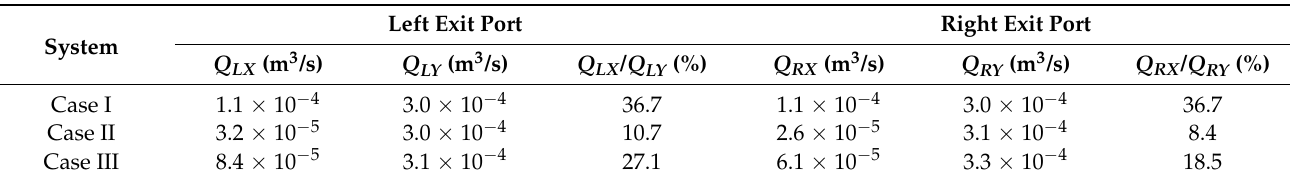
Figure 9. Hydrodynamic behavior of three particular systems. ( a ) Case I, FB-nozzle with inclined inflow. ( b ) Case II, FBFD-nozzle with inclined inflow. ( c , d ) Case III, a modified WB-nozzle with 20 mm of well depth and perpendicular flow dividers. The letters A and B label the exit ports’ sides. Table 3. Oriented volumetric flows for systems analyzed in Figure 9.